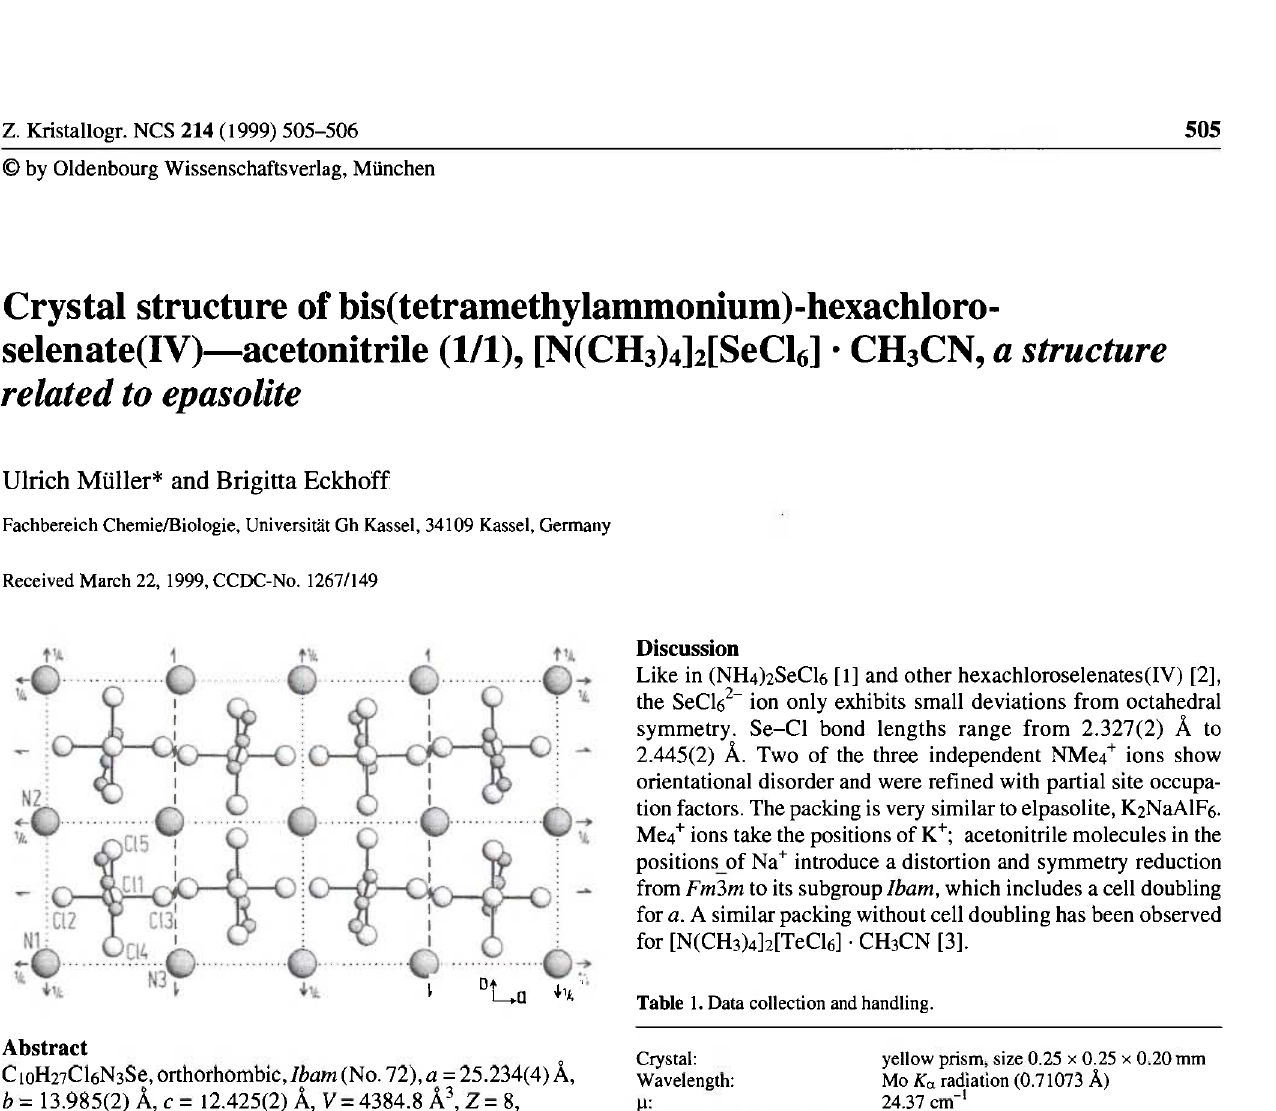
Table 1. Data collection and handling.